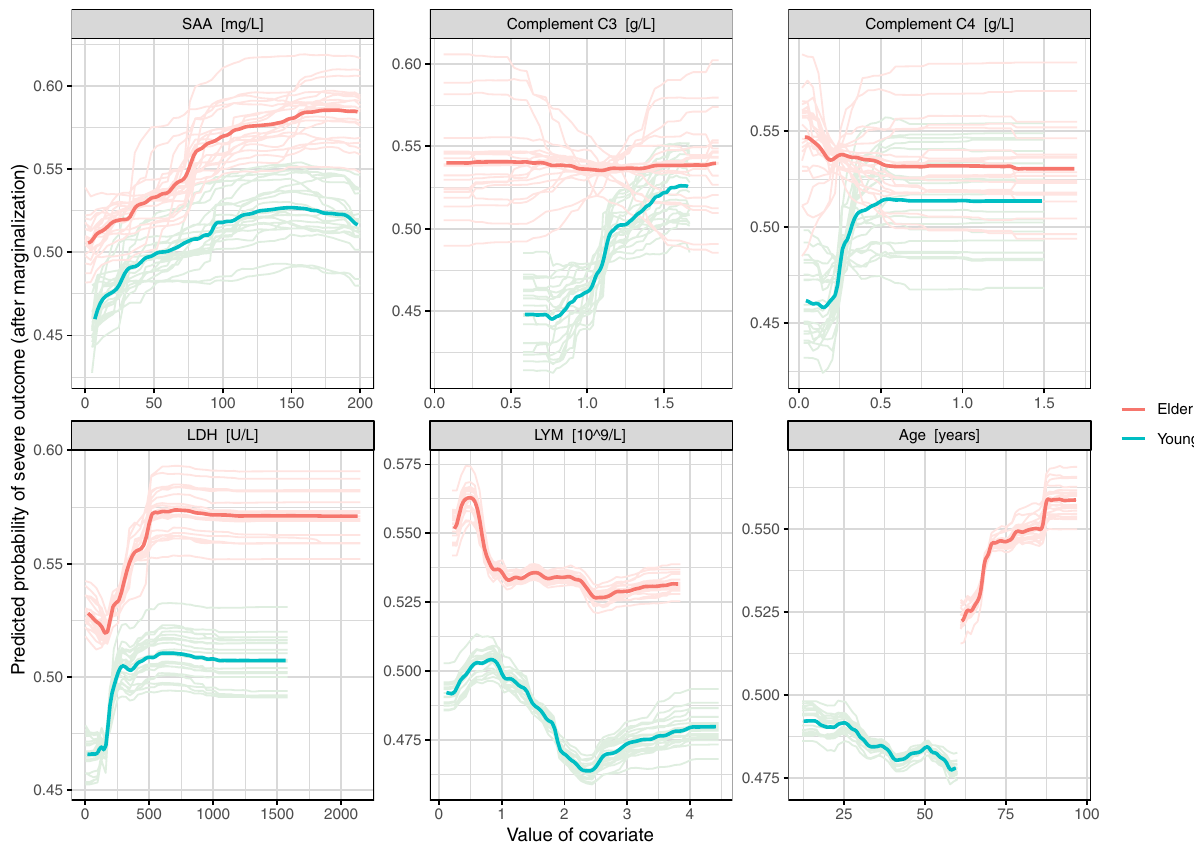
Figure 2. Partial dependence plots (PDPs) for young and elderly patients calculated using random forests. In simplified terms, a PDP shows the influence of a covariate on the outcome after adjusting for the influences of the other covariates. The PDPs for the five variables with largest AUC importance values in young patients and that for ’age’ are shown. The light lines show the 20 individual PDPs calculated using the imputed data sets from the multiple imputation. The bold lines show averages over the 20 individual PDPs.